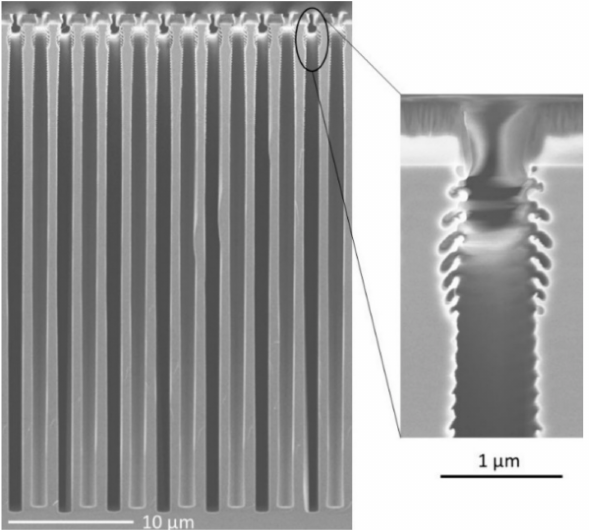
Figure 2. Extended scalloping visible at the top of deep trenches etched with the STiGer process— 1 µ m SiO 2 mask, CD = 800 nm, depth = 39.5 µ m—1.5 s passivation (50 sccm SiF 4 , 50 sccm O 2 , 1500 W source, 30 V bias, 1.5 Pa), 3.5 s etch (150 sccm SF 6 , 1500 W source, 90 V bias, 3 Pa), 360 cycles, T = − 115 ◦ C, Alcatel 601E ICP